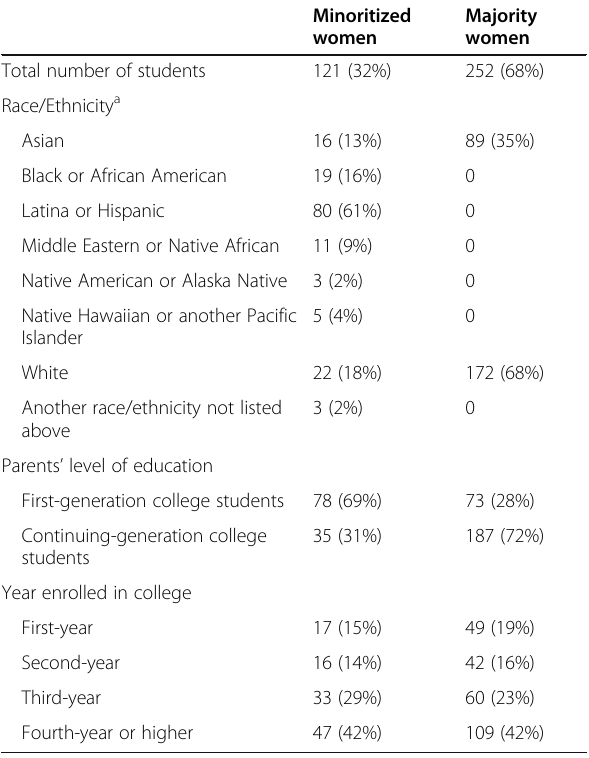
Table 1 Demographics of women in engineering used in this